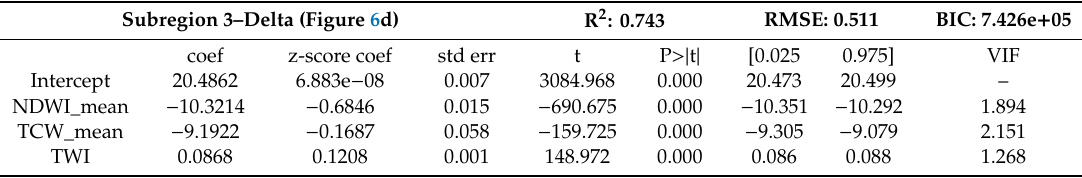
Table A6. Multiple linear regression output as obtained for the subregion “Delta”.